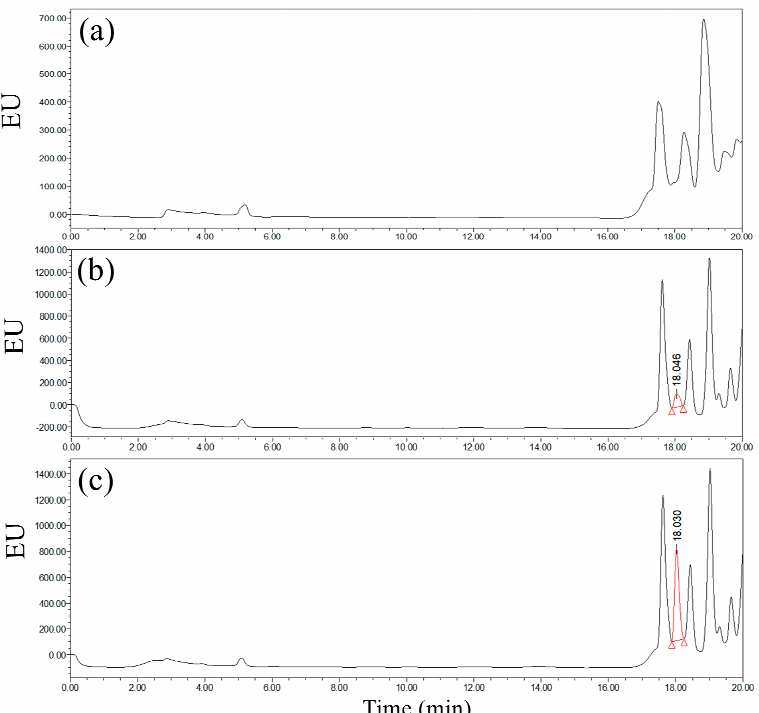
Figure 6. Chromatograms on the ACE-C 18 column for the ( a ) sample derived from the blank control, ( b ) sample derived from the 0.1 mg/L GLUF-P matrix solution, and ( c ) sample derived from the 0.5 mg/L GLUF-P matrix solution.